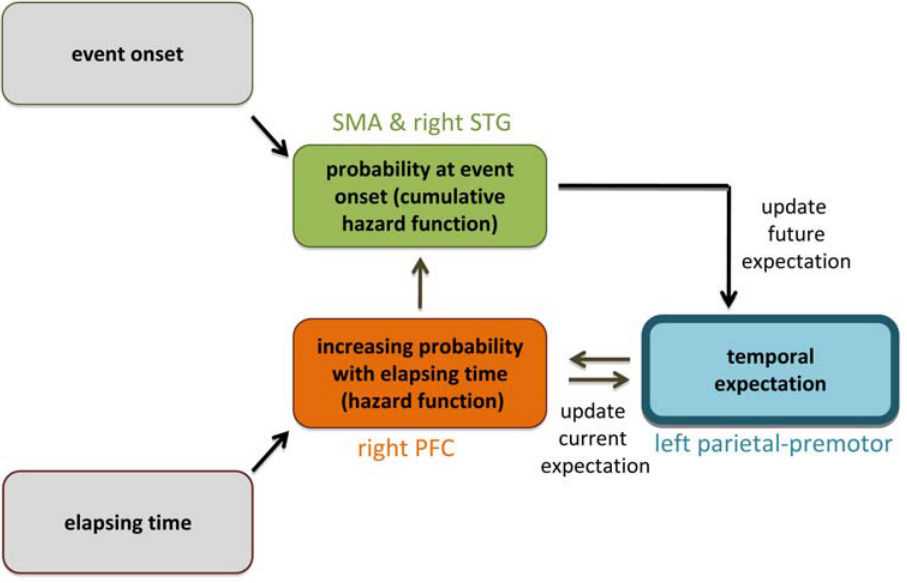
Figure 2. Temporal expectation in the brain. Fixed temporal expectations of when a visual event is likely to occur are underpinned by activity in left premotor and parietal areas [7,26]. However, if the event has still not appeared by the expected delay, the right prefrontal cortex (PFC) [21–25] makes use of neural indices of elapsed time (represented in functionally specialized regions of the brain e.g., in visual cortex for visual events [15]) to update current temporal expectations (i.e., the hazard function). Once the event occurs, an integrated sum of the probability that the event would have occurred at that time (i.e., the cumulative hazard function) is represented by the magnitude of activity in SMA and right STG [14], and allows expectations about the onset time of future events to be